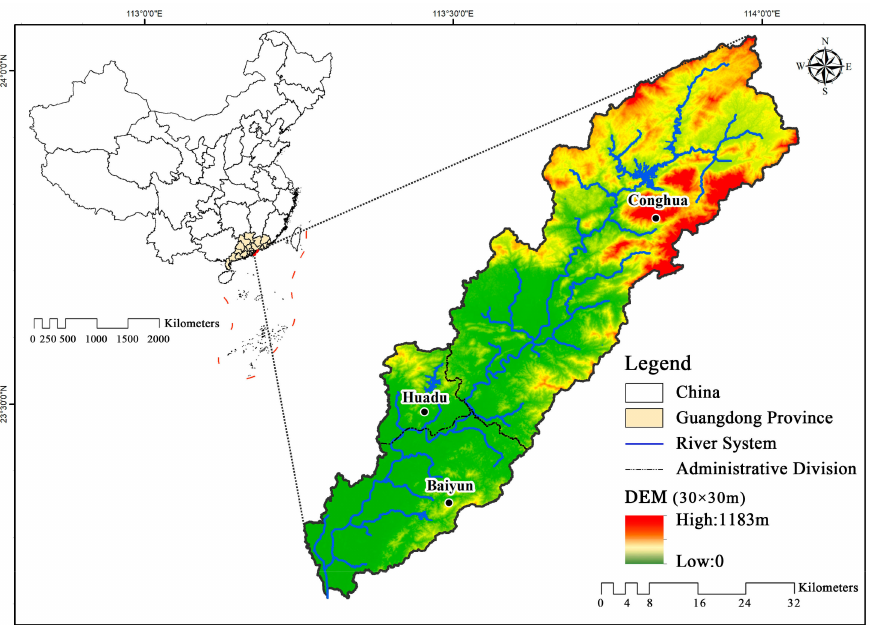
Figure 1. The location and digital elevation map (DEM) of the Liuxihe River basin (LXH). Spatial data such as topographical elements (digital elevation map (DEM) and SLOPE) were obtained from NASA’s Earth Observing System Data and Information System (https://search.earthdata.nasa.gov/search, accessed on 30 December 2018). And other spatial data were obtained from Data Center for Resources and Environmental Sciences, Chinese Academy of Sciences (Source: China, Satellite images, http://www.resdc.cn, ac- cessed on 30 December 2018), including population density (TP), socioeconomic level (GDP), urbanized activities (NLD), and land use intensity (LUIN). These main parameters of the LXH with a spatial resolution of 1000 m (except for the DEM and SLOPE data with a spatial resolution of 30 m) were all cut out by the ArcGIS